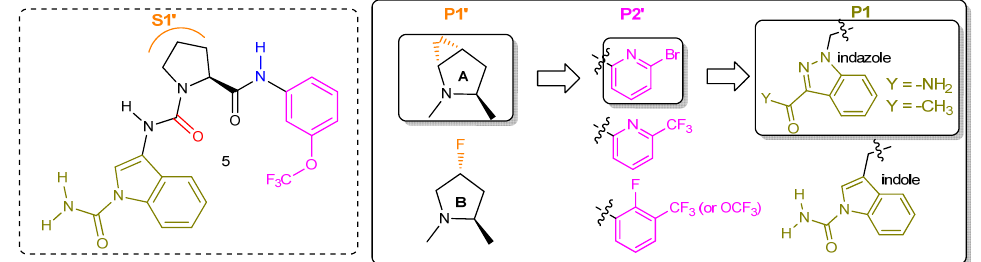
Figure 4. Lead optimization of 5 by segment (P1 ′ , P2 ′ , P1) and in the order shown.